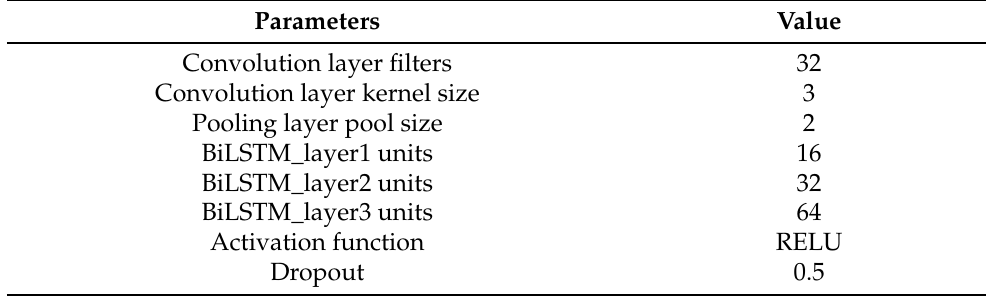
Table 2. Parameter settings for each network layer of the proposed model.